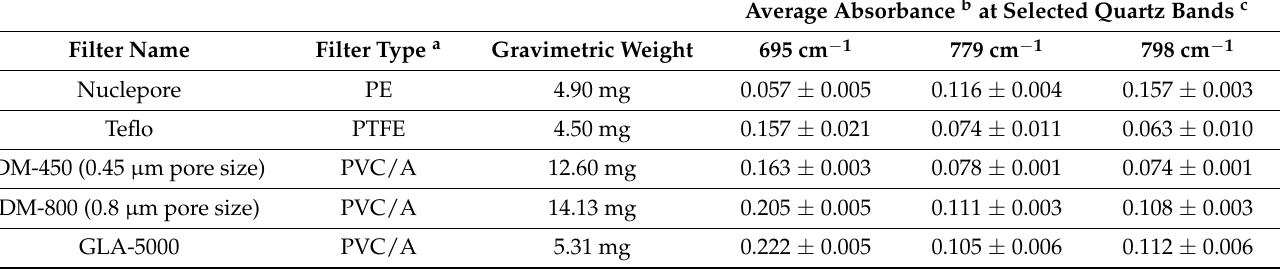
Table 4. Infrared absorbance of five 25 mm-diameter membrane filters